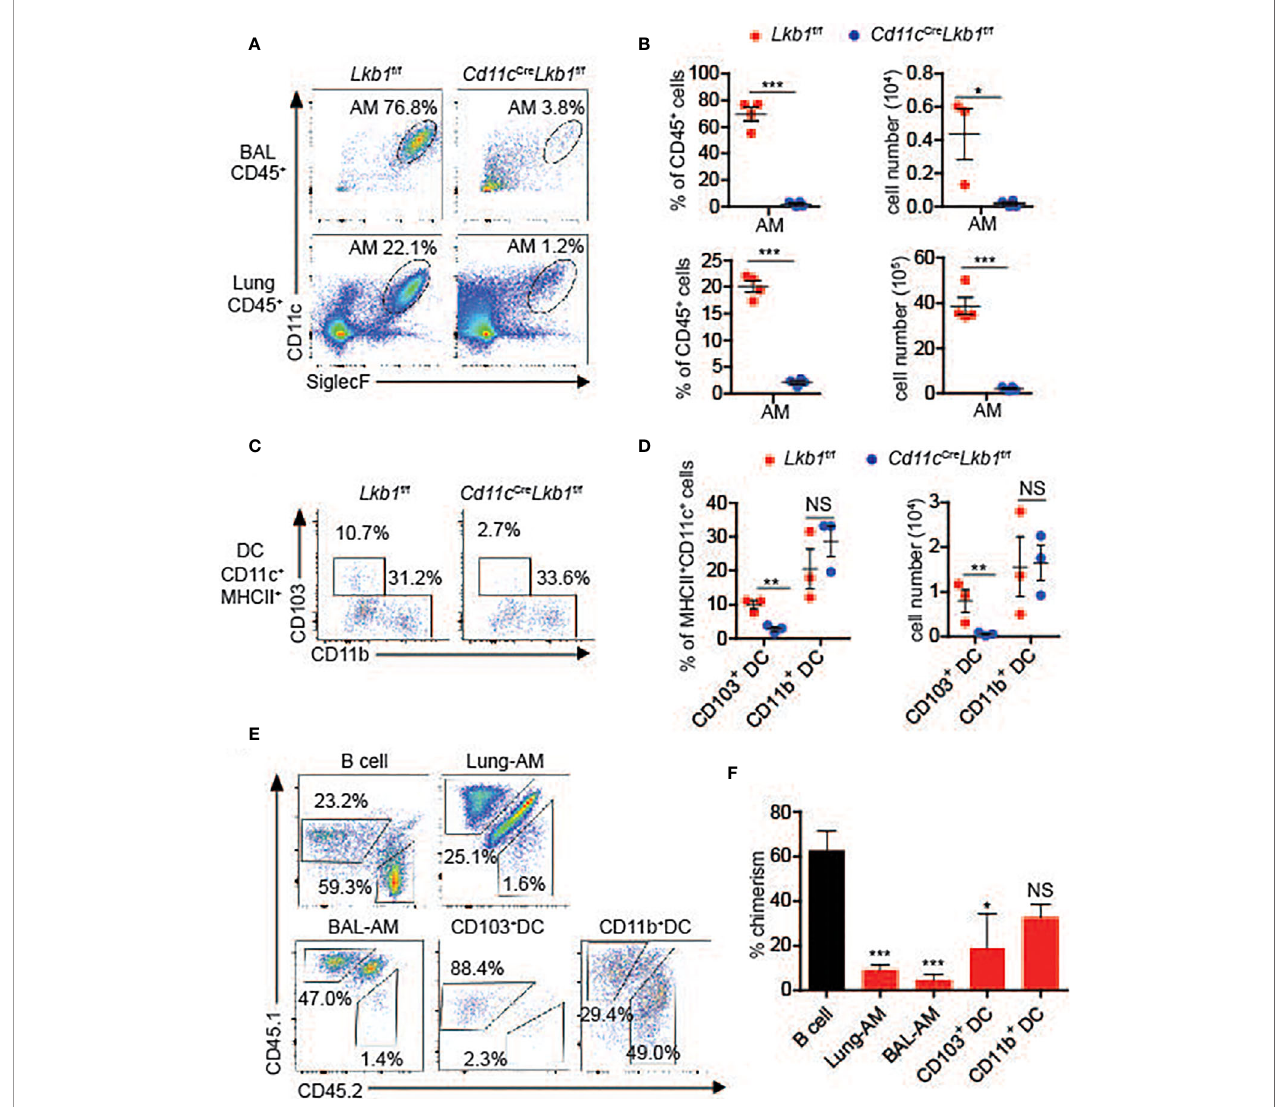
FIGURE 1 | Loss of Lkb1 leads to a marked reduction in AMs in Cd11c Cre Lkb1 f/f mice. (A) The AM frequency among CD45 + leucocytes in BAL fl uid and lungs from Lkb1 f/f mice and Cd11c Cre Lkb1 f/f mice was analyzed by fl ow cytometry. (B) The percentages and absolute numbers of AMs in BAL fl uid and lungs from Lkb1 f/f mice and Cd11c Cre Lkb1 f/f mice (n = 4). (C) Flow cytometry analysis of CD103 + and CD11b + DC frequencies among CD11c + MHCII + DCs in the lungs of Lkb1 f/f mice and Cd11c Cre Lkb1 f/f mice. (D) The percentages and absolute numbers of CD103 + and CD11b + DCs in the lungs of Lkb1 f/f mice and Cd11c Cre Lkb1 f/f mice (n = 4). (E) Mixed bone marrow chimeras were established by mixing Lkb1-de fi cient (CD45.2) BM cells and wild type (CD45.1) BM cells (3:1) and transferring them to CD45.1 + CD45.2 + host mice. Chimeras were analyzed by fl ow cytometry. (F) The bar chart shows the frequency of chimerism contributed by Lkb1-de fi cient cells to the indicated control B cells (n = 3 – 5). Each symbol (B, D) represents a mouse, and the results are presented as the mean ± S.D., NS (not signi fi cant), P > 0.05, * P < 0.05, ** P < 0.01, *** P < 0.001, (by Student ’ s t -test) (B, D, F) . All data represent at least three independent